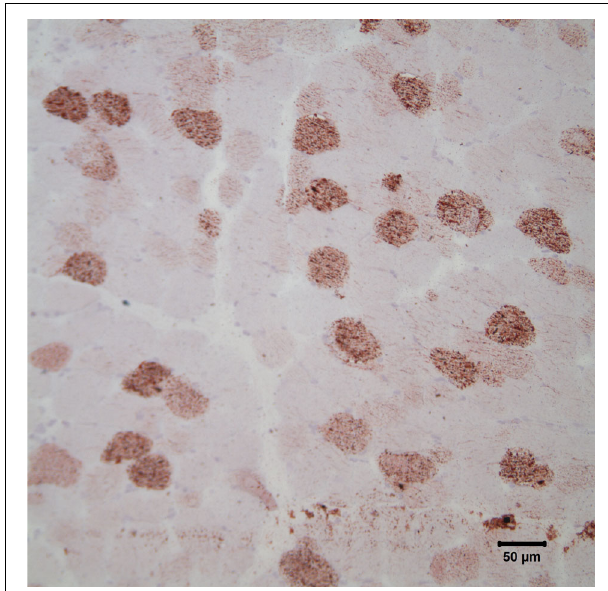
FIGURE 3 | Photomicrograph of cryosections of the triceps muscle stained with oil red O stain reveals the presence of numerous intramyofiber lipid droplets, consistent with a lipid storage myopathy . Oil red O stain; bar = 50 (cid:22)